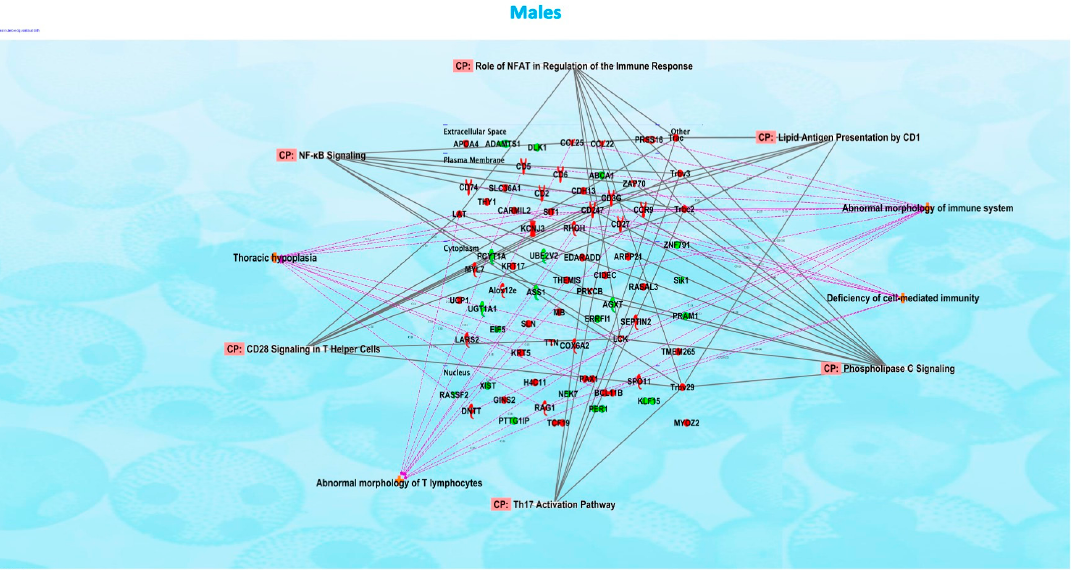
Figure 2. Ingenuity Pathway Analysis revealed that networks of inter-connected genes for protein- coding genes were associated with CD28 signaling in T-helper cells, Th17 activation pathway, and phospholipase C signaling in the male offspring mice exposed in utero to vanilla-flavored e-cig aerosol and sacrificed at birth.